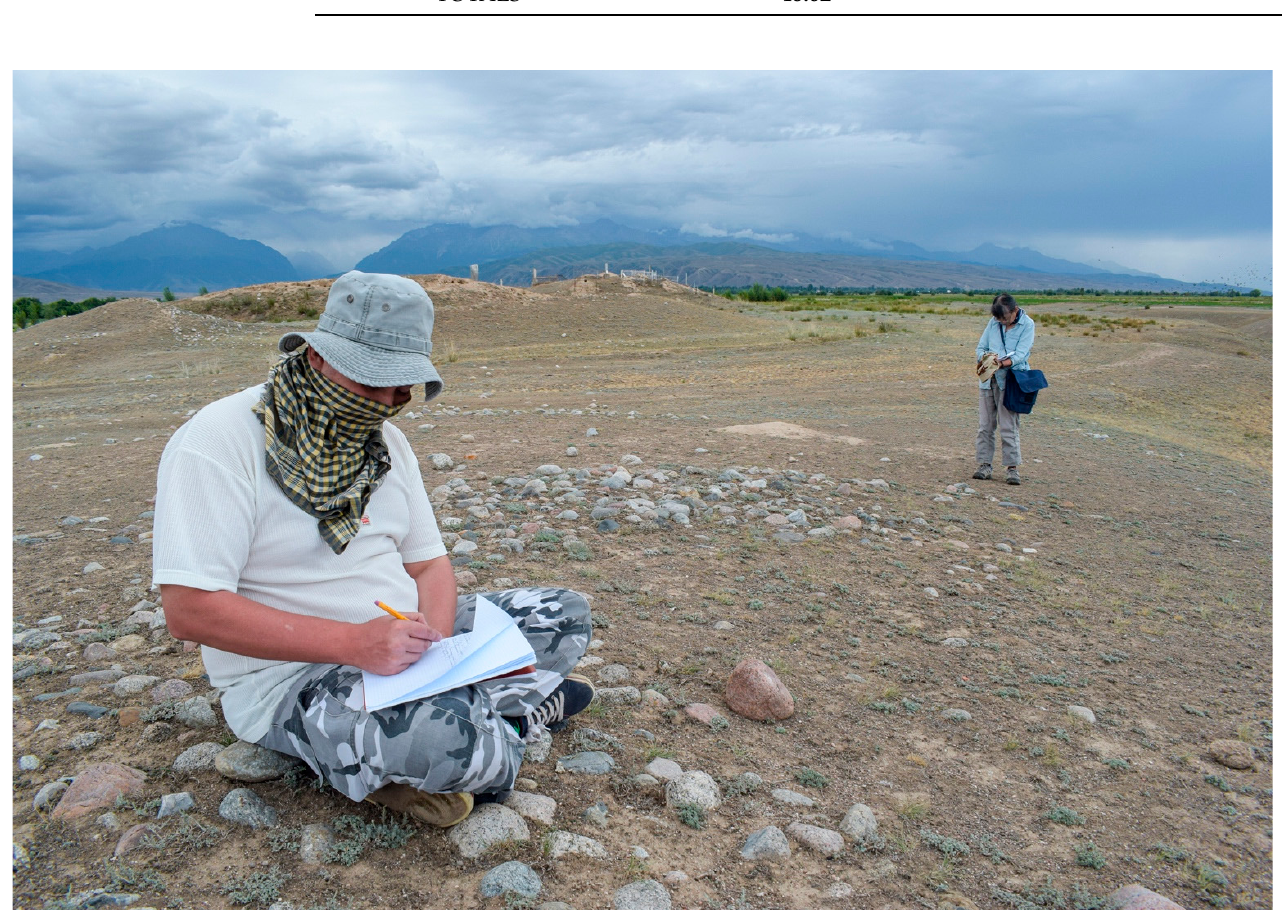
Figure 3. Recording stone kurgans in the Lower Kizil Suu. Large earthen Saka kurgans in the background.